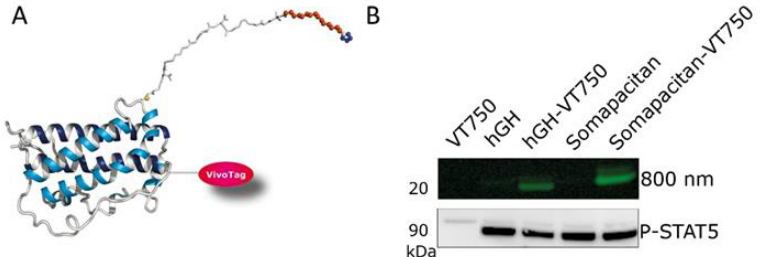
Figure 3. Qualification of fluorescently labelled GH and somapacitan. ( A ) GH analogs were random labelled with the near-infrared fluorescent label VT-750, here is shown somapacitan randomly labelled with VT-750. ( B ) Labelled analogs were qualified in primary rat hepatocyte stimulation assay at 8 nM for 15 min treatment. Cell lysates were run on SDS-PAGE, gel scanned at 800 nm to confirm labelling, and Western blotted with P-STAT5. Included as controls were unlabeled GH and somapacitan and VT750 tag alone.